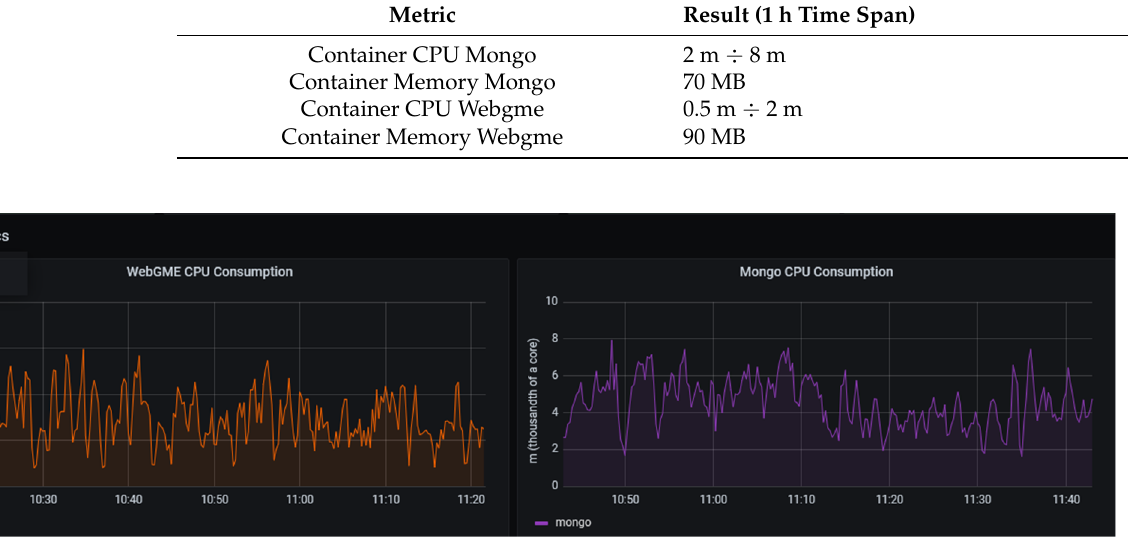
Figure 5. Mongo and WebGME pods CPU consumptions. Table 10. Prometheus monitoring results for containers.